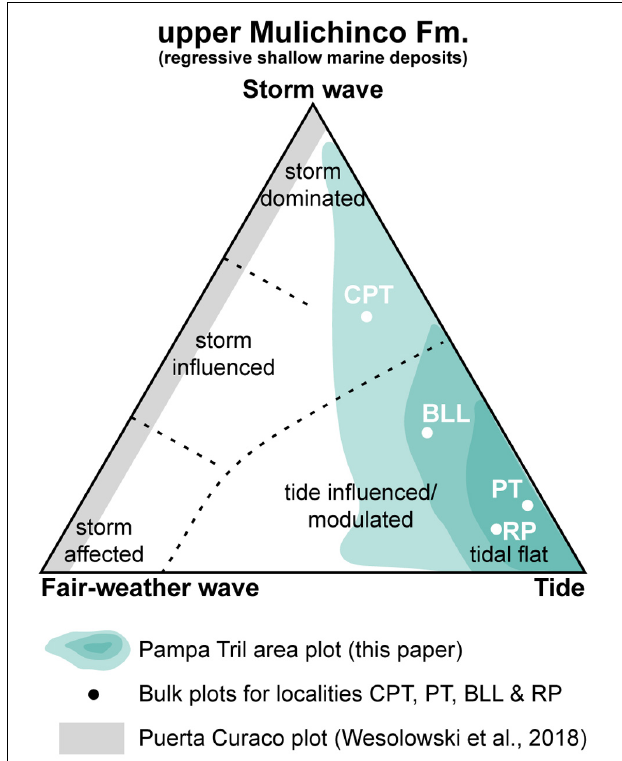
FIGURE 12 | Ternary diagram for shoreface environment, modified from Dashtgard et al. (2012) to include tidal flat environment; plots include upper Mulichinco Fm. bulk locality plots for this study’s four study localities, approximate bulk plot for the study area in blue-green, and bulk plot for the Puerta Curaco area in gray (Wesolowski et al., 2018). CPT, Cerro Pampa Tril; PT, Pampa Tril; BLL, Barranca Los Loros; RP, Río Pequenco, see